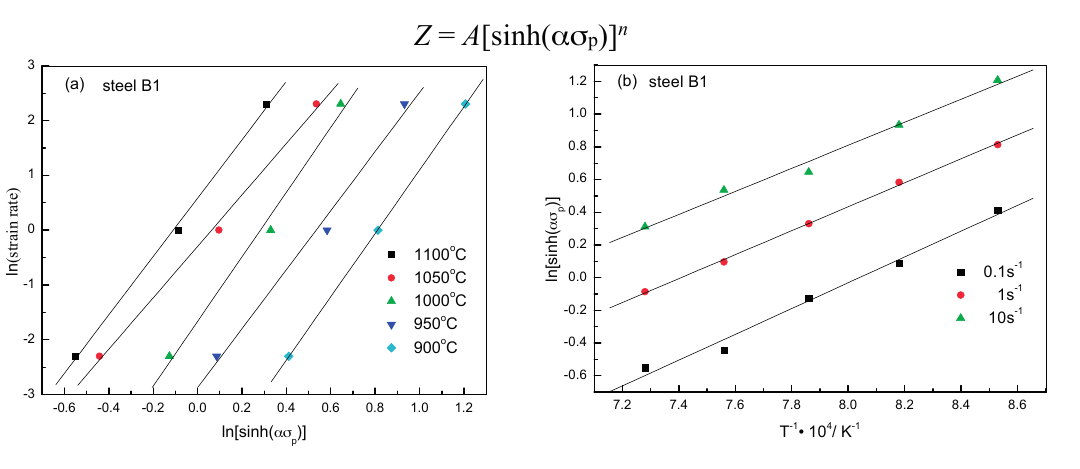
Figure 7. Relationship between ln[sinh(  p )] and ( a ) ln(strain rate); ( b ) T − 1 .